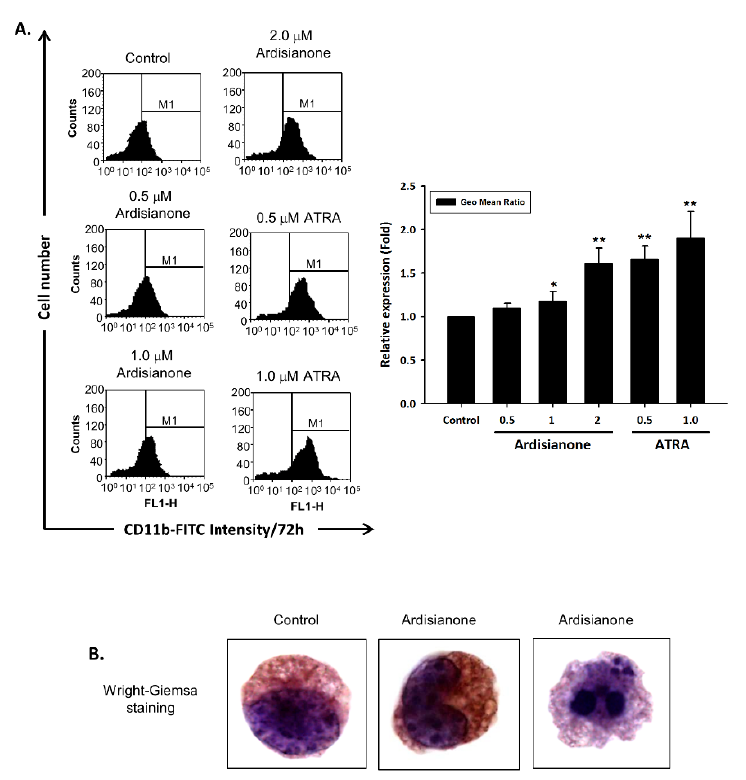
Figure 7. Effect of ardisianone on cell differentiation. HL-60 cells were incubated in the absence or presence of ardisianone or all- trans -retinoic acid (ATRA) at the indicated concentration ( A ) or in 2 µ M ardisianone ( B ) for 72 h. Then, the cells were harvested and either incubated with FITC-conjugated anti-CD11b antibody and analyzed by flow cytometry ( A ) or stained with Wright–Giemsa stain solution ( B ) and examined under a light microscope BX56 (Olympus, Japan). * p < 0.05 and ** p < 0.01 compared with the control.